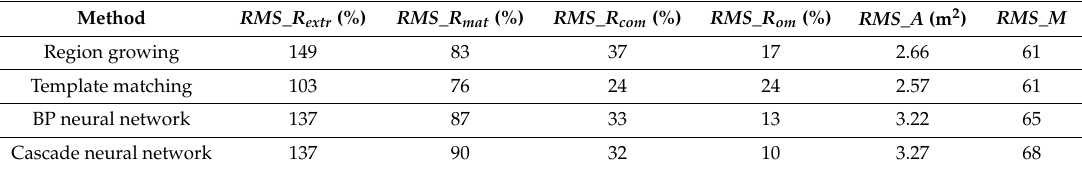
Table 7. Detection results for the six test